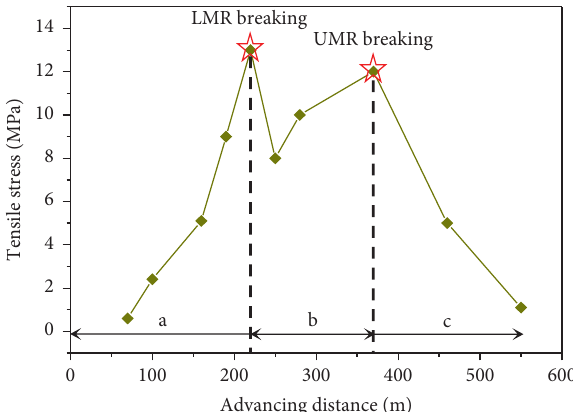
Figure 6: Variation curve of tensile stress before and after double layers of magmatic rock breaking.